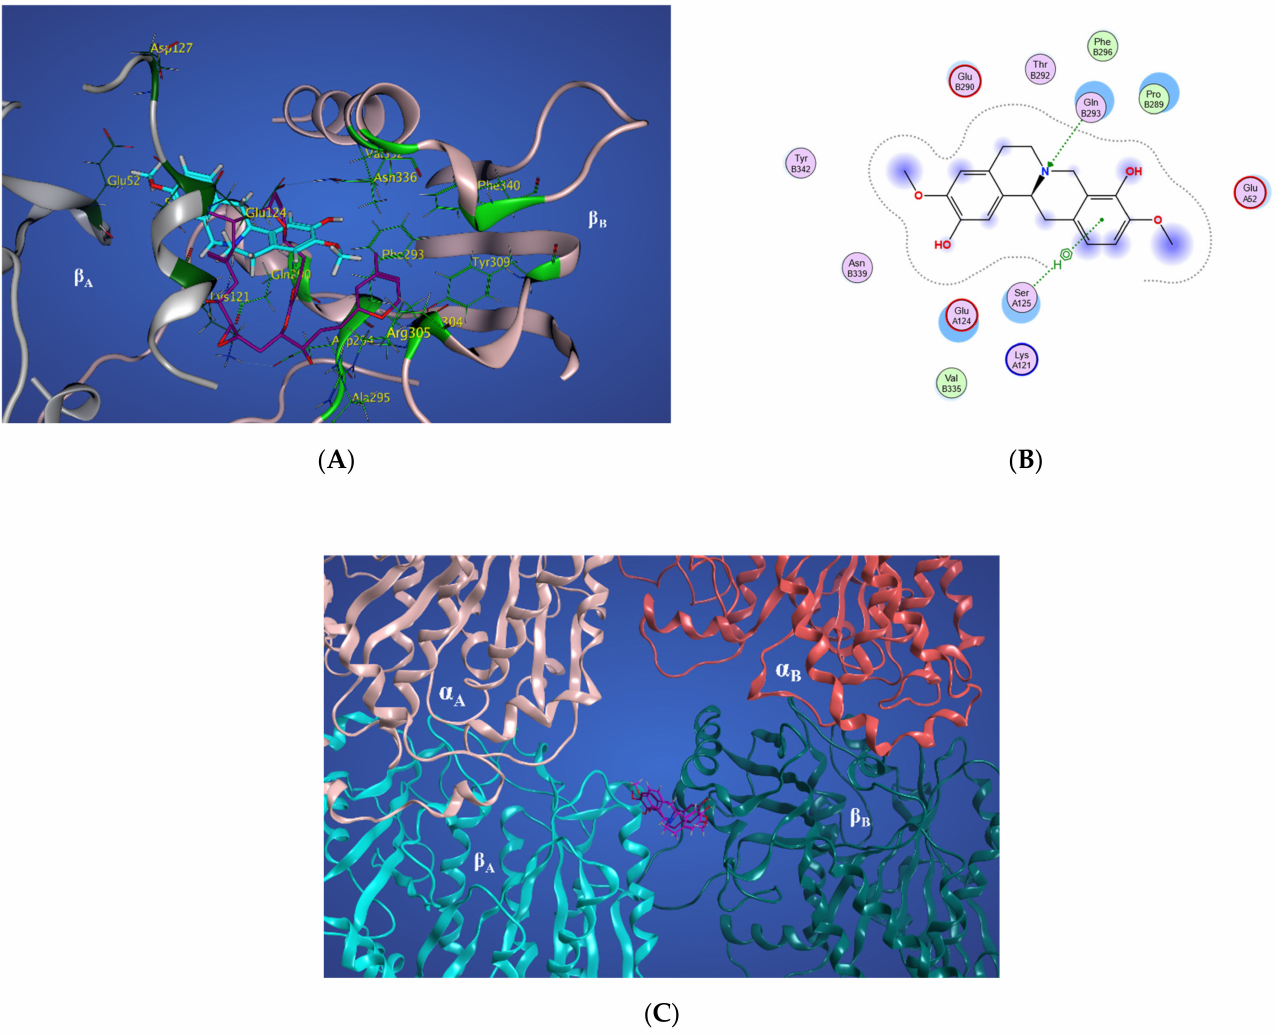
Figure 16. ( A ) Three-dimensional interaction scheme of scoulerine (blue) and a superimposed laulimalide crystal structure from the 4O4H PDB file (purple) between microtubule protofilaments. Residues shown in light green are in the laulimalide site on β A tubulin and residues shown in dark green are in the laulimalide site on β B tubulin. ( B ) Two-dimensional interaction scheme of scoulerine in the laulimalide binding sites on β A tubulin and β B tubulin. ( C ) Representative structures of cluster A (purple) and cluster B (pink) in the laulimalide binding sites. α A and α B tubulins colored in light and dark pink and β A and β B tubulins colored in light and dark green,